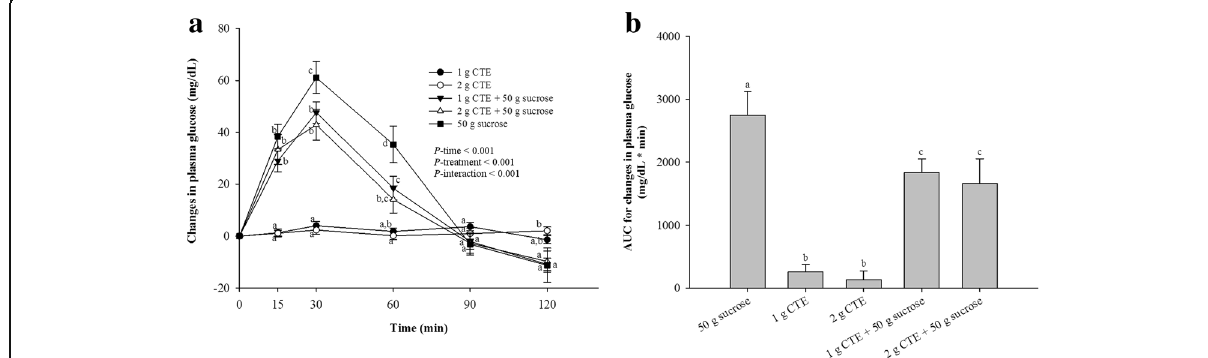
Fig. 2 Postprandial plasma glucose response of five different beverages. a Changes in glucose concentrations during 120 min of five different beverages; ( b ) Glucose changes area under the curves (AUCs) of five different beverages. Values are means ± SEM, n = 15. Different letters are significantly different ( P <